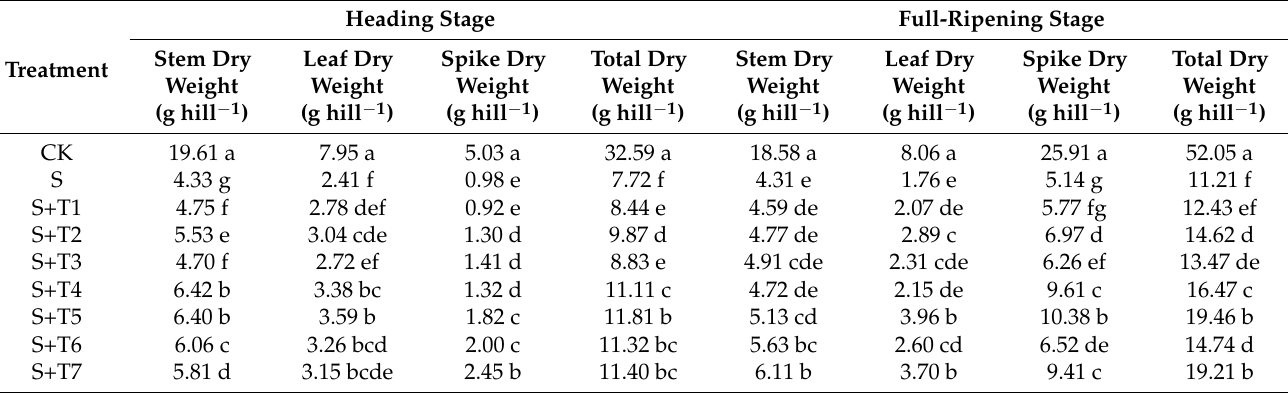
Table 5. Rice dry weight at different growth stages.